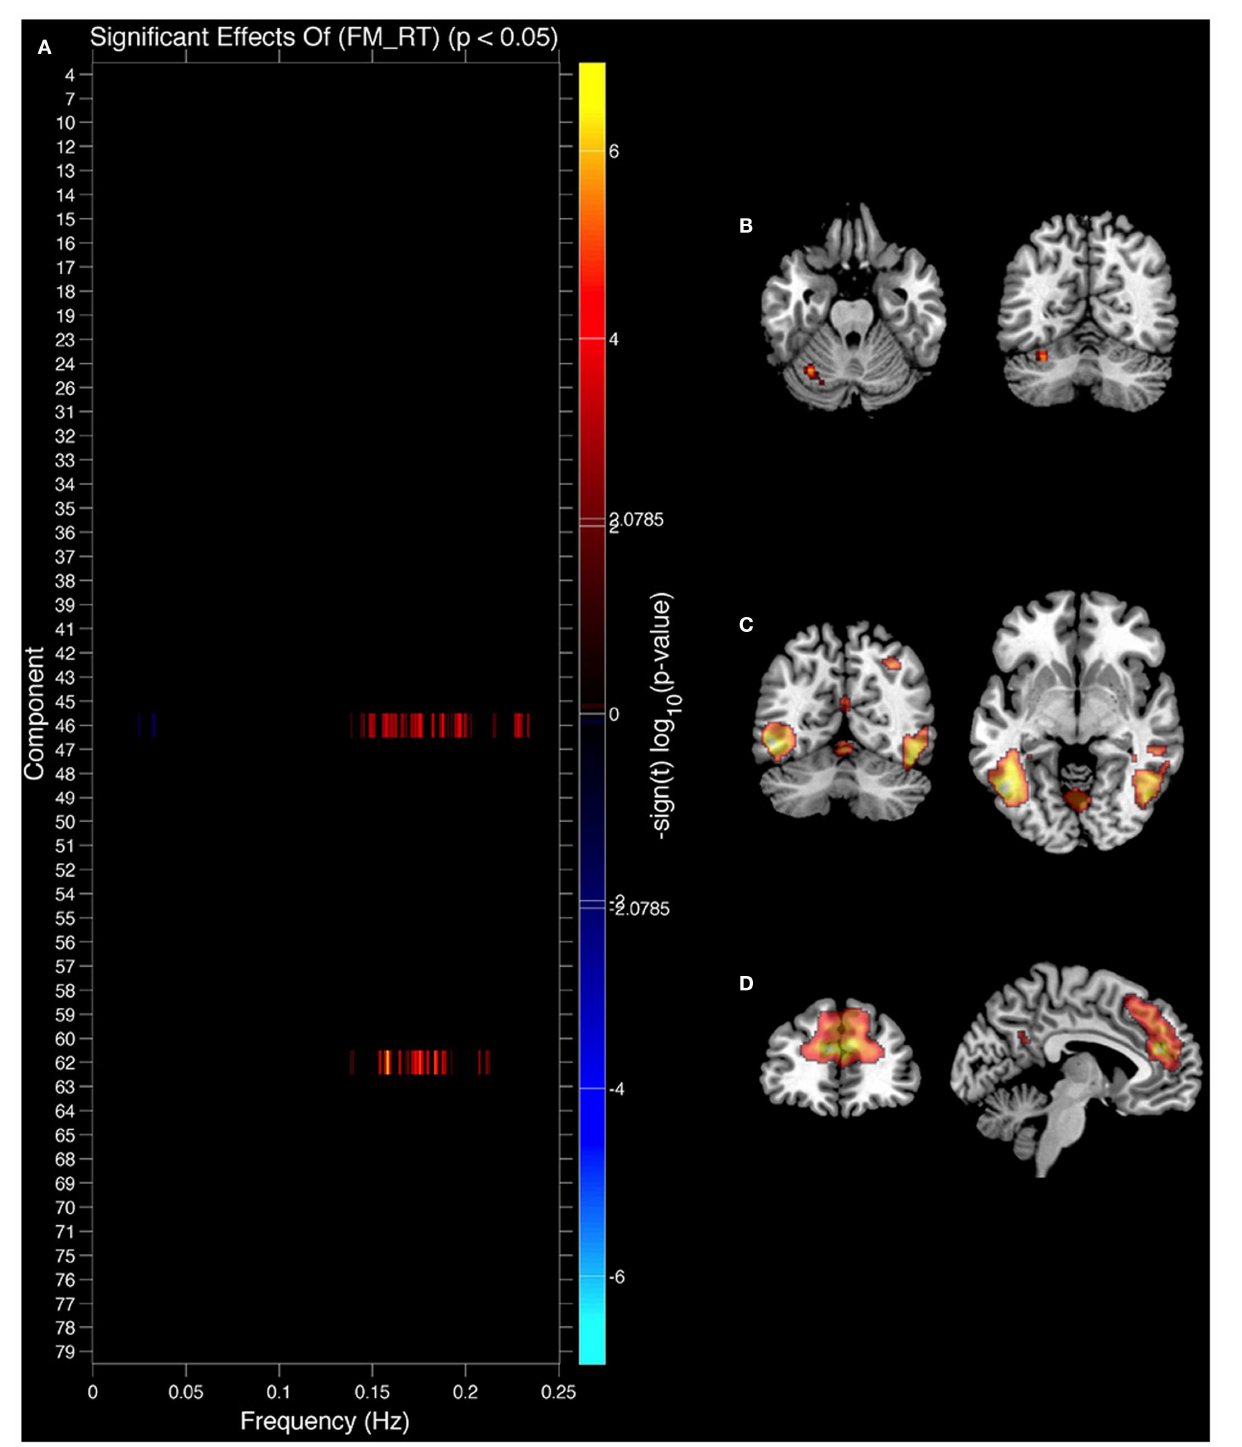
significant difference after correcting for multiple comparisons. (B) Significant covariation with voxel intensity and face match RT within left cerebellar lobule HVI. (C) IC 46 spatial map. (D) IC 62 spatial map. All results are FDR thresholded ( p <